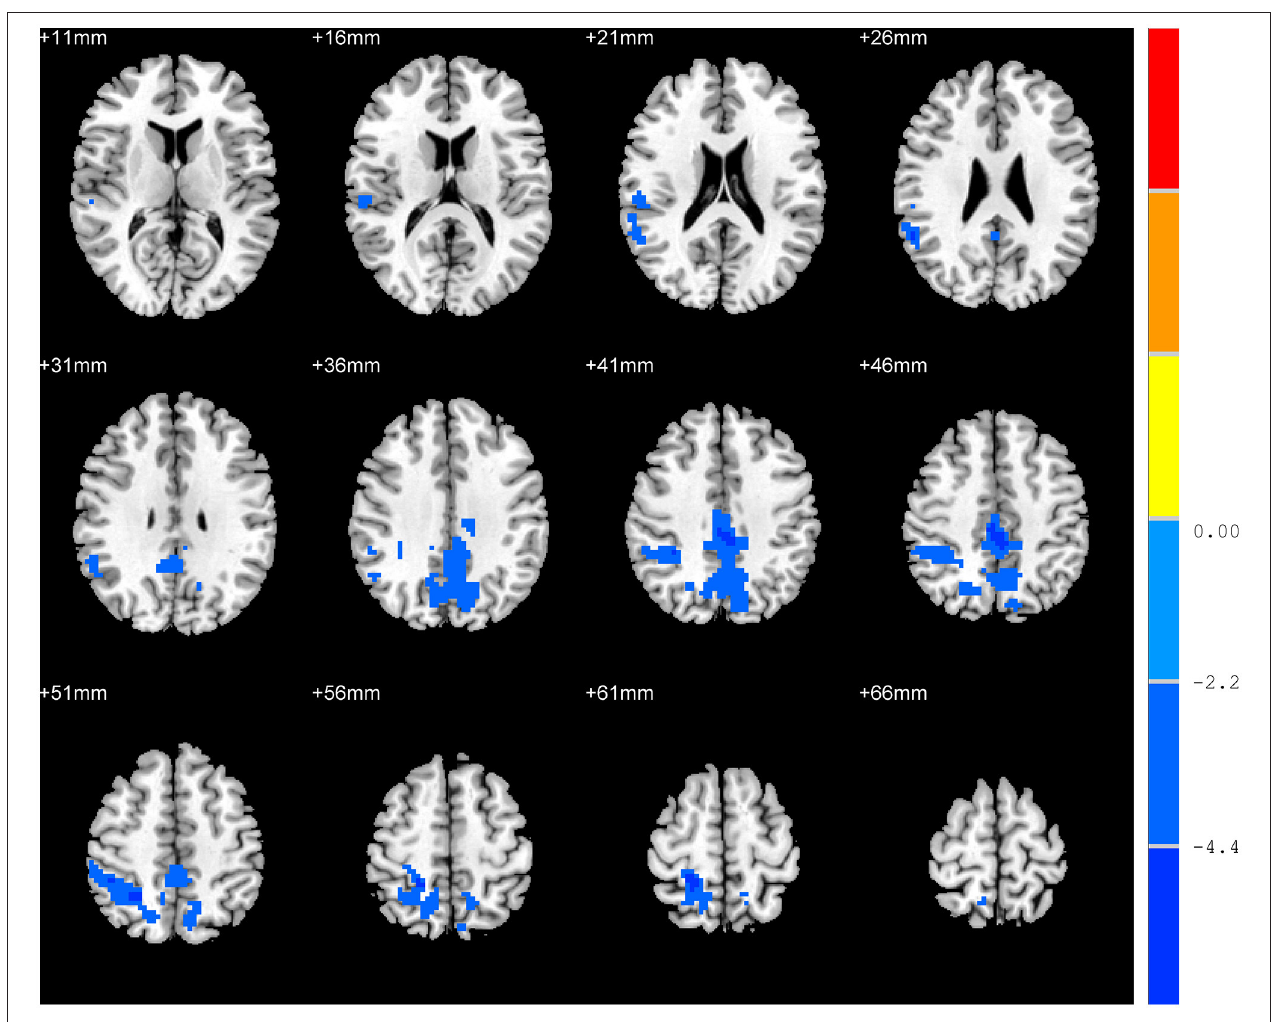
FIGURE 1 | Differences in the amplitude of low-frequency fluctuation between residual dizziness group and without residual dizziness group.